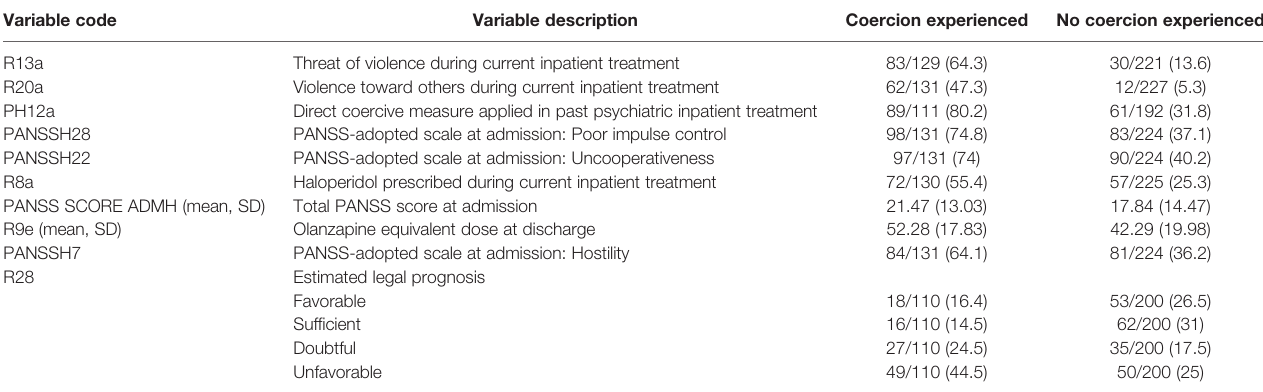
TABLE 3 | Absolute and relative distribution of relevant predictor variables.